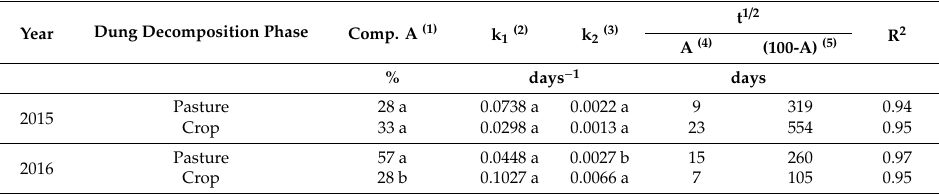
Table 4. Parameters of double exponential models fitted to phosphorus release rates from sheep dung, calculated half-life values (t 1 / 2 ), and coe ffi cient of determination (R 2 ) at di ff erent decomposition phases during the 2015 and 2016 annual cycle of a no-till integrated soybean-sheep production system. Results are the averages of low and moderate grazing intensities.